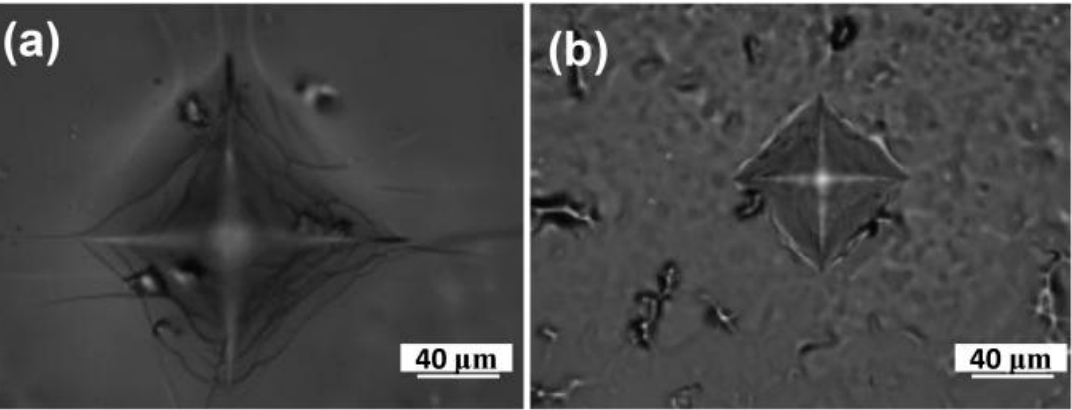
Table 1. Bulk impedance, grain boundary resistance, and ionic conductivities of composite solid electrolytes with different content of LATP.